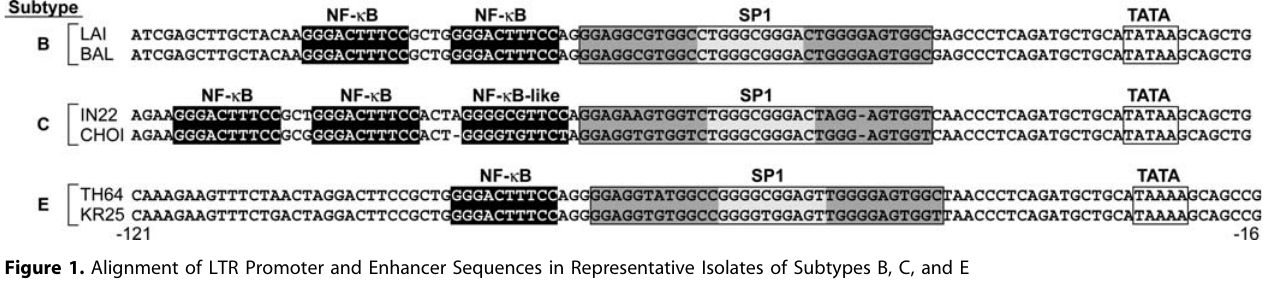
Figure 1. Alignment of LTR Promoter and Enhancer Sequences in Representative Isolates of Subtypes B, C, and E Sequence variation within the NF- jb /NFATp, SP1, and TATA box regions that distinguish the C and E subtypes from the B subtype are indicated in the boxes. Sequences were aligned and analyzed by using ClustalW